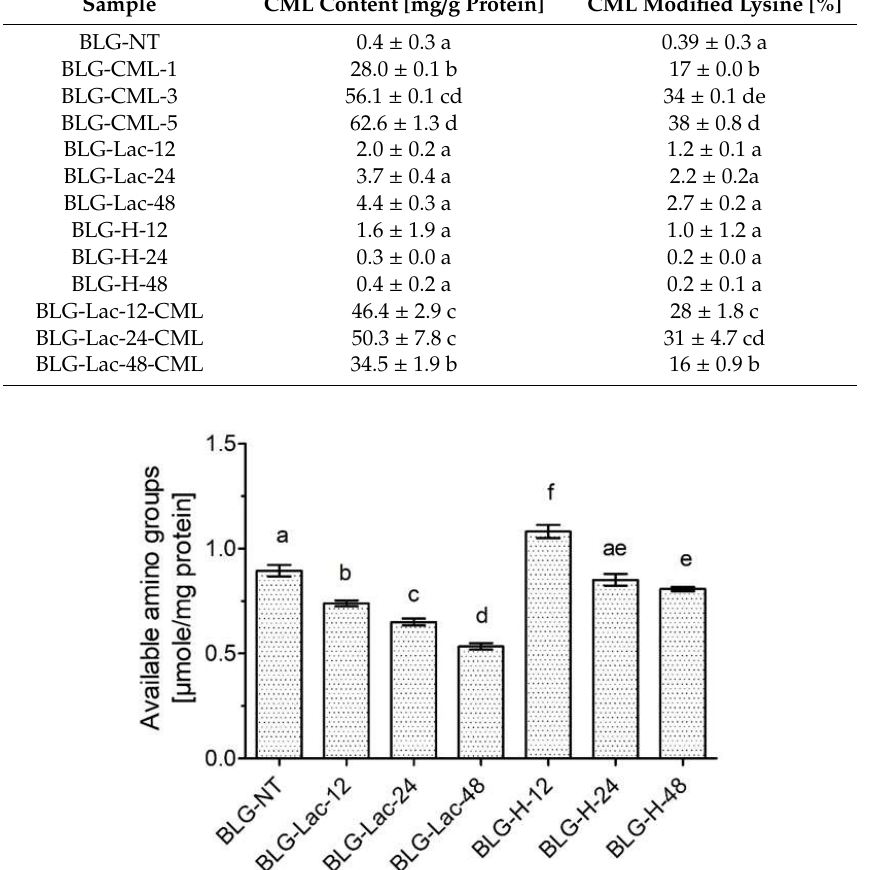
Figure 1. Available amino groups of β -lactoglobulin (BLG), non-treated (NT), glycated with lactose (Lac) by heating at 60 ◦ C for 12, 24, and 48 h, as well as heated at 60 ◦ C for 12, 24, and 48 h in the absence of any sugars (H). Error bars represent standard deviation of technical replicates ( n = 3). Statistical di ff erences were tested using one-way ANOVA with Tukey post-hoc test. Significant di ff erences were considered at p < 0.05, where two variables have di ff erent letters if they are significantly di ff